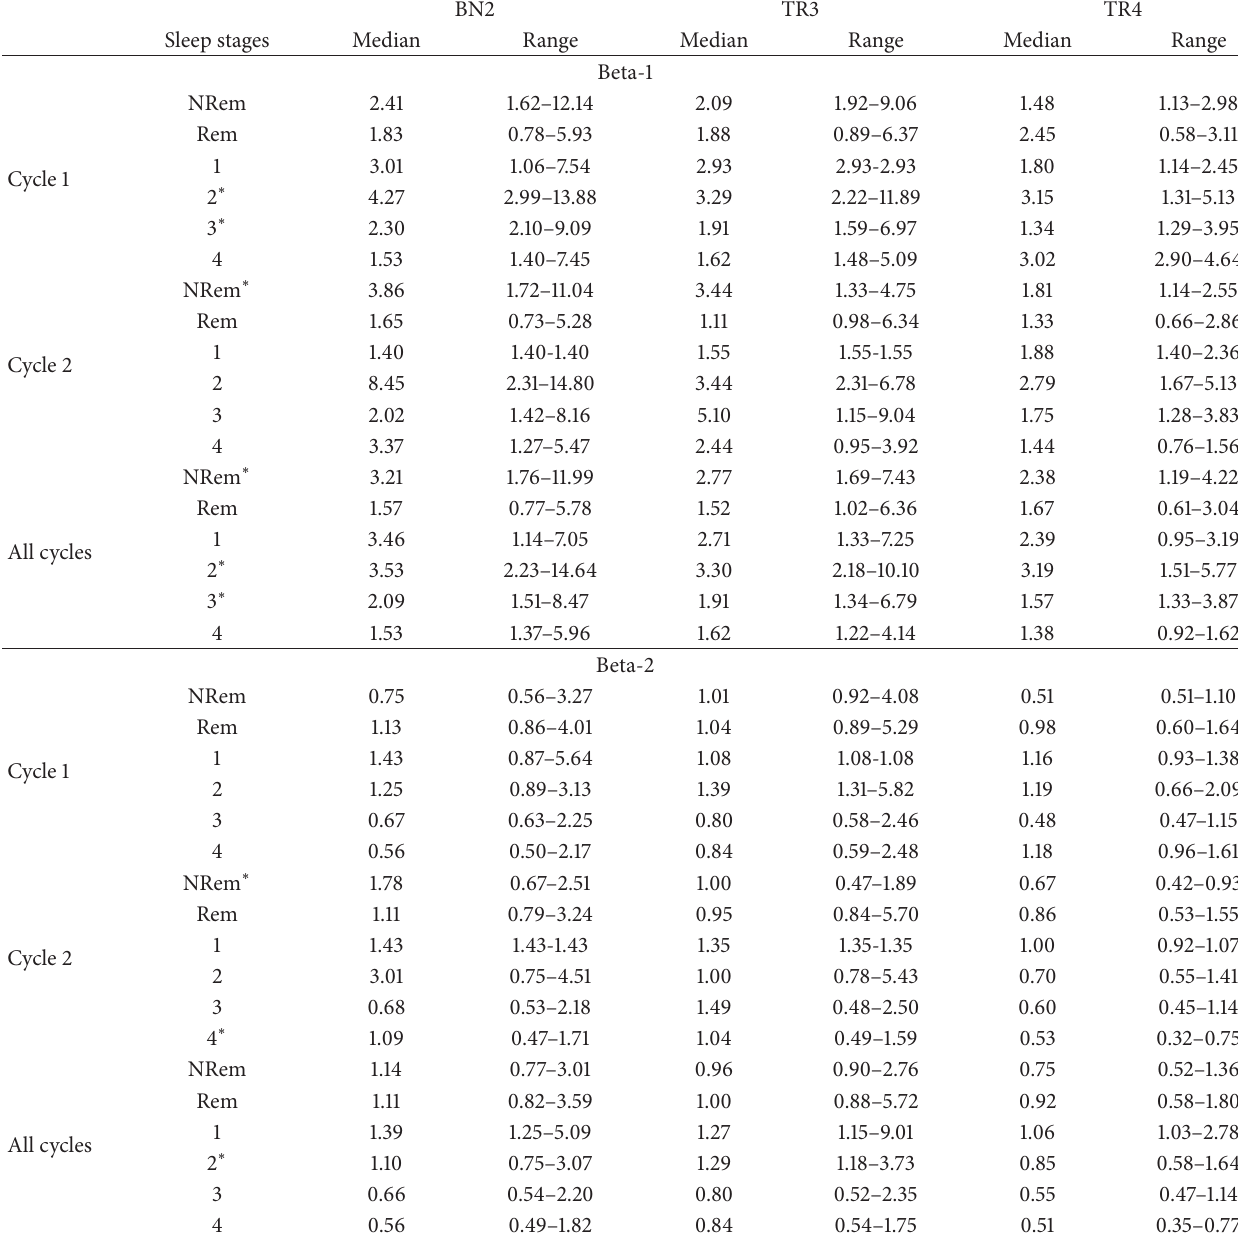
Table 5: Median (range) power values for responders for beta-1 and beta-2 band